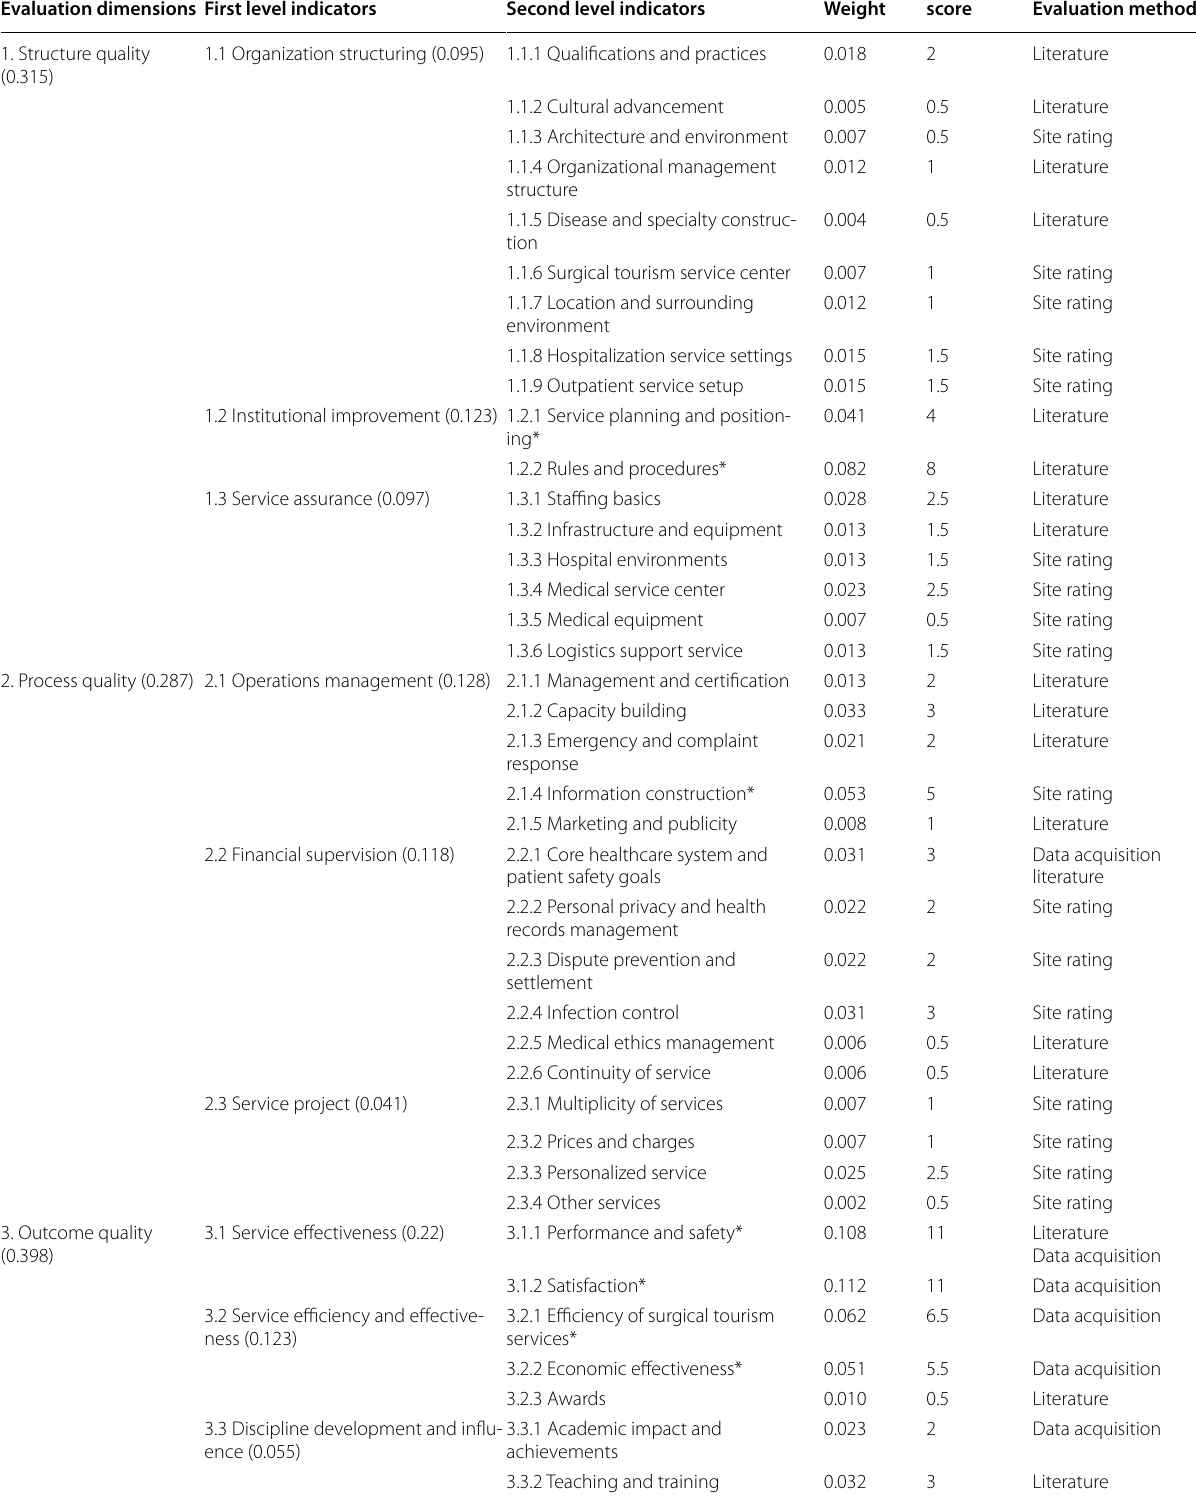
Table 3 Evaluation indicator weight and score table of surgical tourism service organizations Evaluation dimensions First level